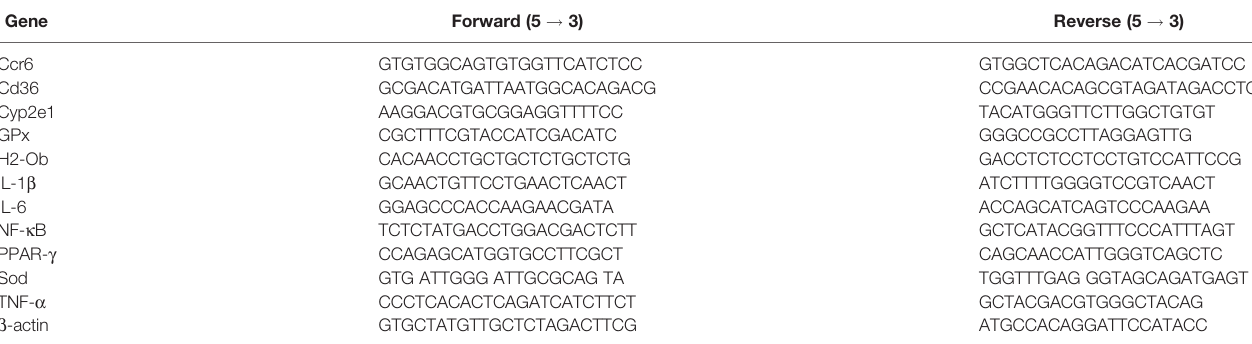
TABLE 1 | Gene-special primers used in qRT-PCR. Gene